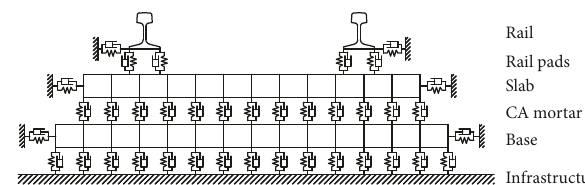
Figure 4: Structural model of the rail-track